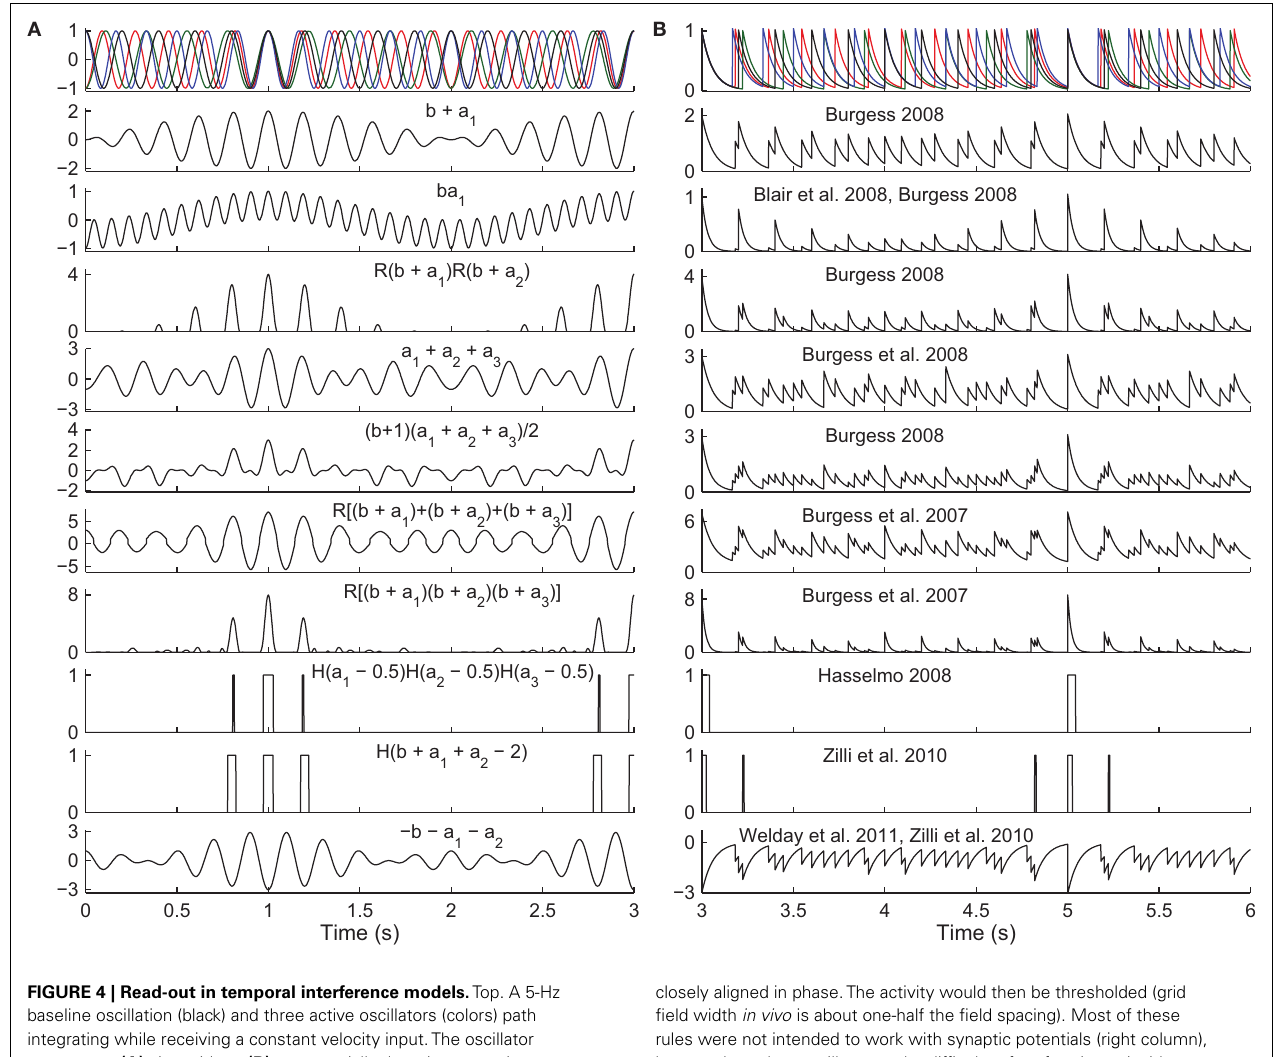
FIGURE 4 | Read-out in temporal interference models. Top. A 5-Hz baseline oscillation (black) and three active oscillators (colors) path integrating while receiving a constant velocity input.The oscillator outputs are (A) sinusoids or (B) exponentially decaying synaptic potentials (50ms time constant).The simulated animal begins between grid fields at time t = 0s and enters fields at times t = {1,3,5}s.The remaining rows show the output of various models in response to the input oscillations (some using fewer than three active oscillator inputs). The rules all aim to produce maximal activity when the oscillators are all